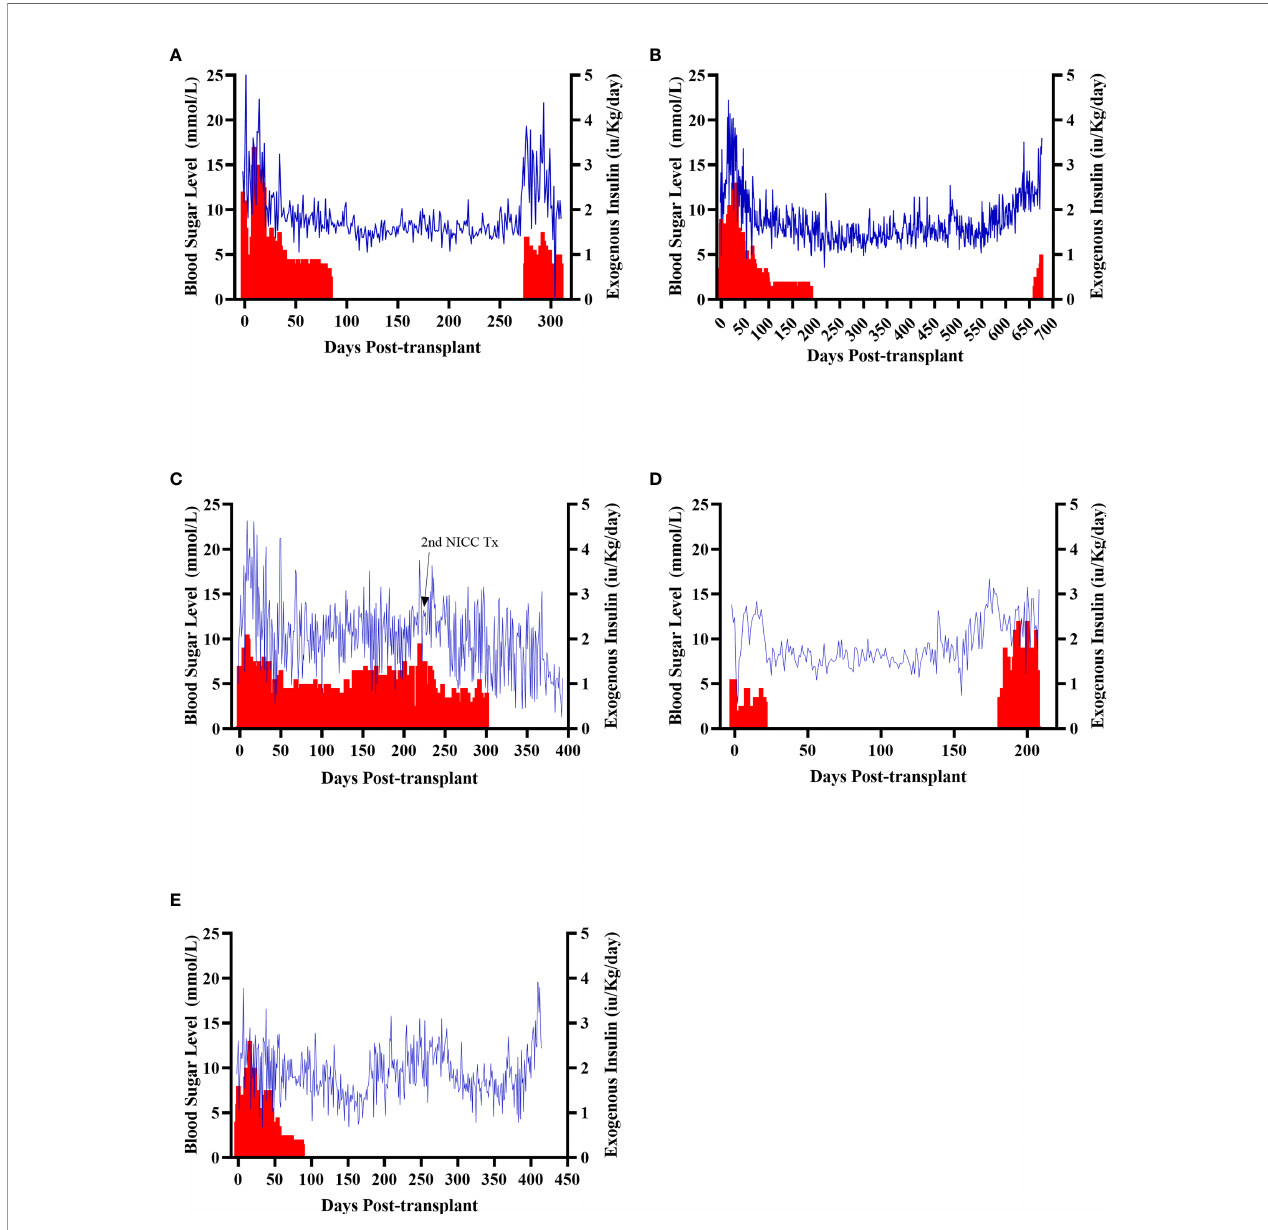
FIGURE 4 | Early morning fasting blood sugar levels (blue) and daily insulin requirements (red) for all recipients. Recipients S1 (A) , B1 (B) , F1 (C) , W1 (D) , O1 (E)